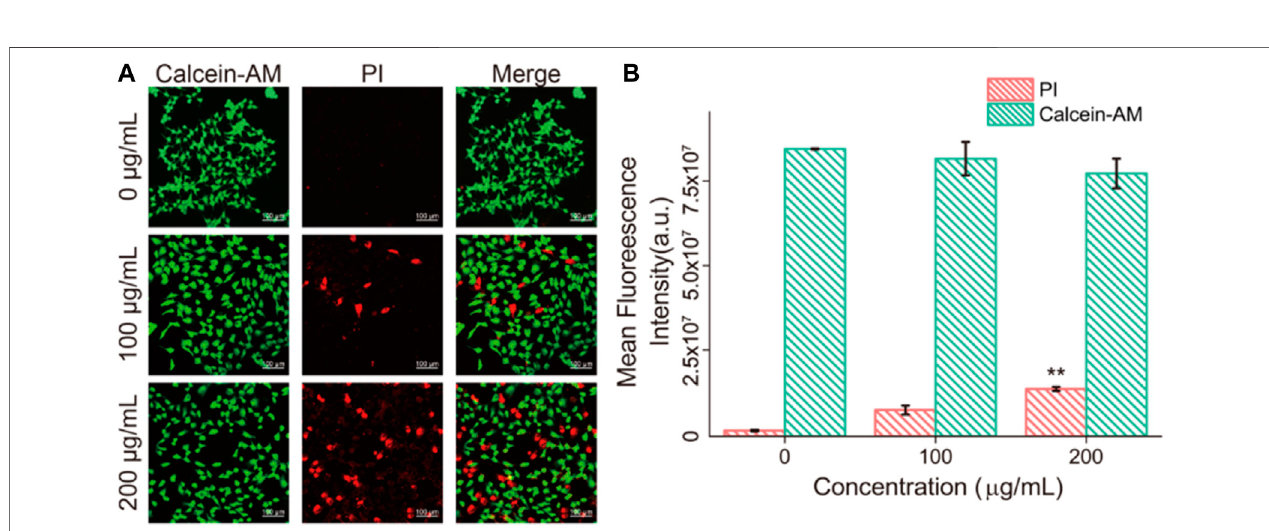
FIGURE8| (A) HBE cells dead/live were detected by PI/Calcein-AM (red/green) after co-incubation with differentconcentration ofFe 3 O 4 /GO after 24 h(scale bar: 100 μ m). (B) Mean fl uorescence intensity of PI/Calcein-AM after co-incubation for 24 h.